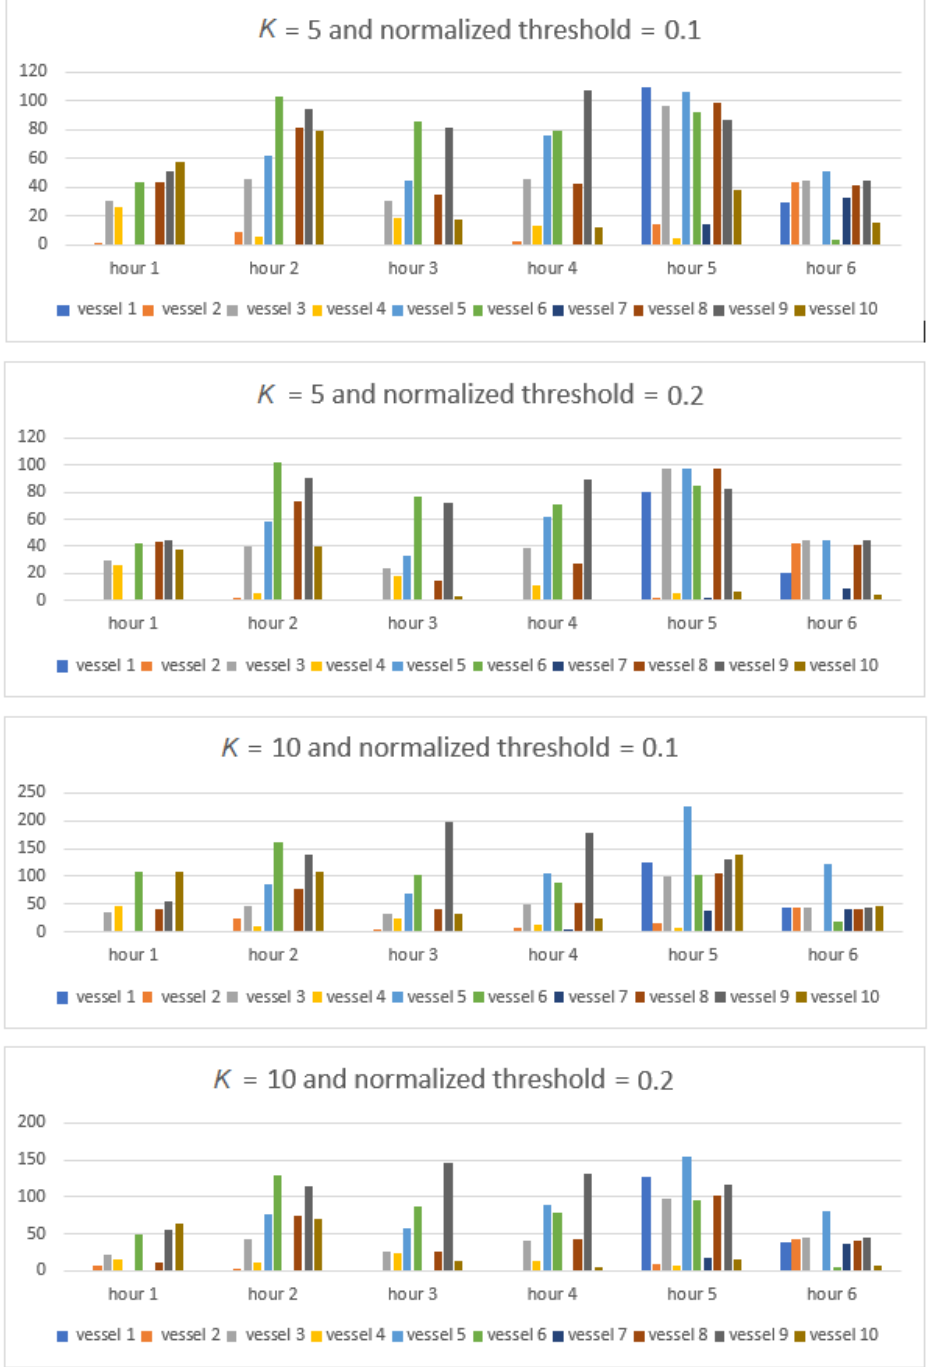
Figure 24. Number of vessel detections inside selected contours. Based on all previous analyses, the assessment of vessel detectability was made. Tables 1 and 2 show the final